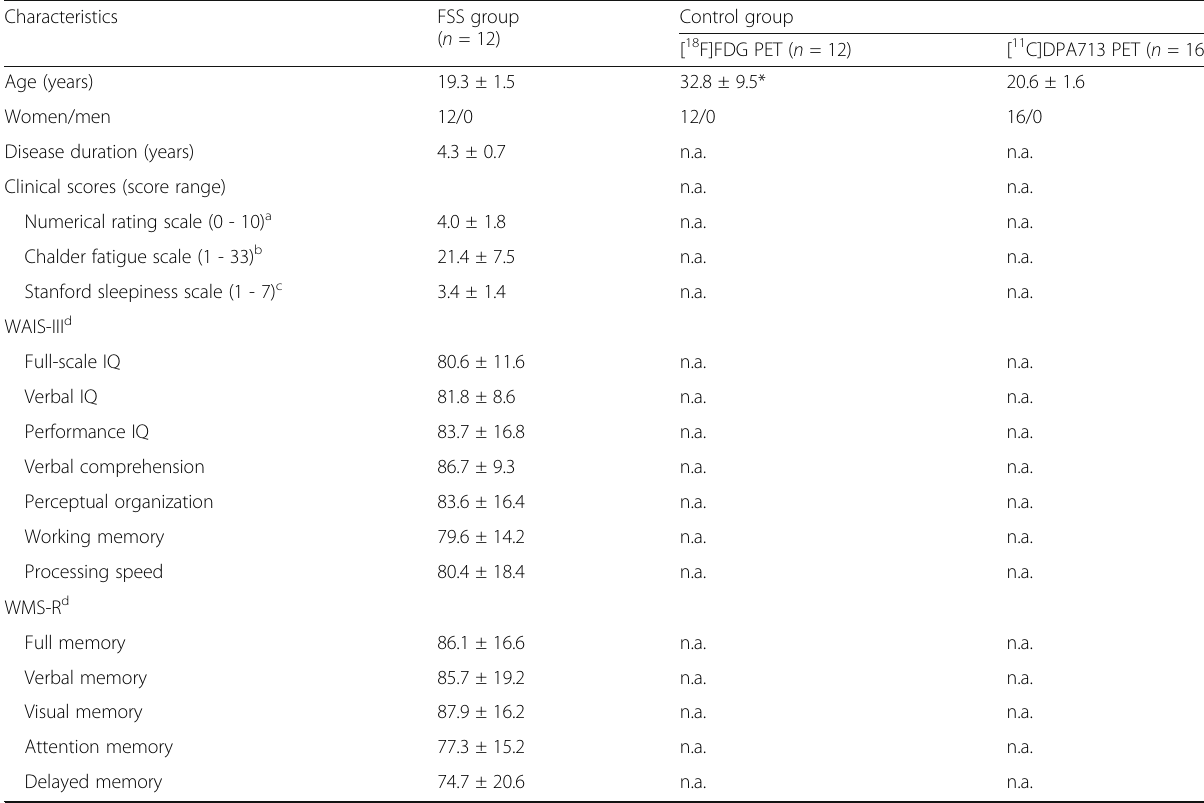
Table 1 Demographic and clinical characteristics of the study participants